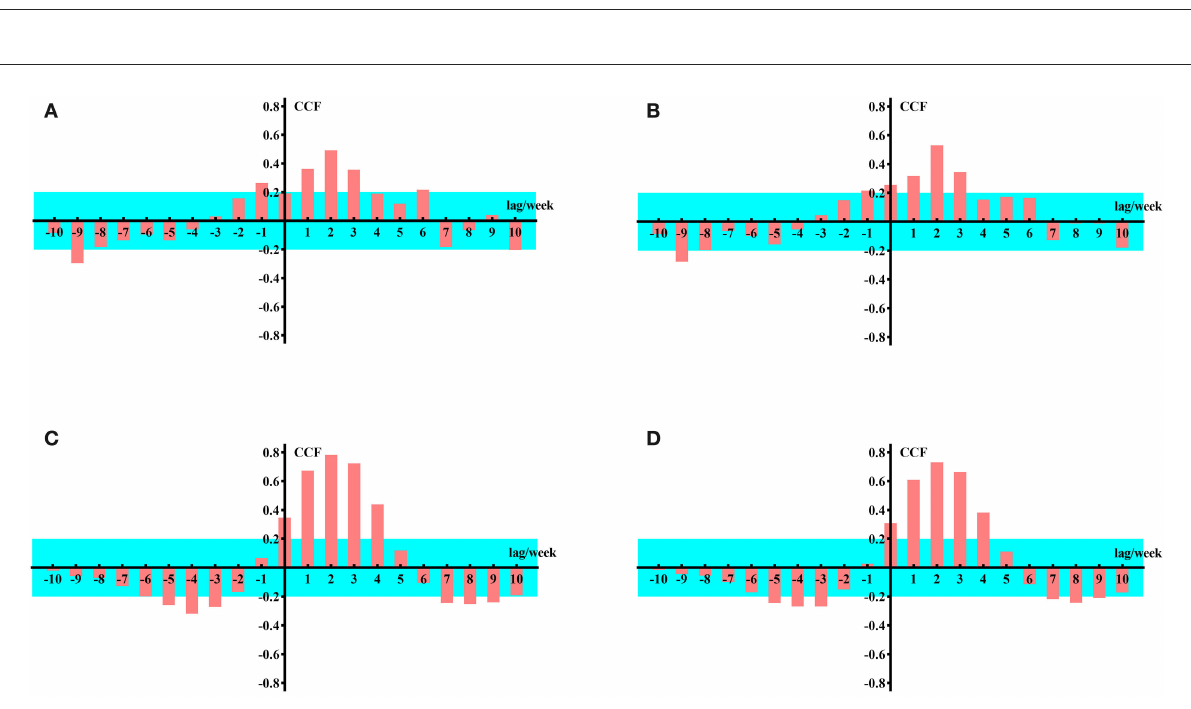
FIGURE4 Cross-correlation function values for data from the United States and India. (A) Google Trends data for United State loss of smell as the input sequence. (B) Google Trends data for United State loss of taste as the input sequence. (C) Google Trends data for loss of smell in India as